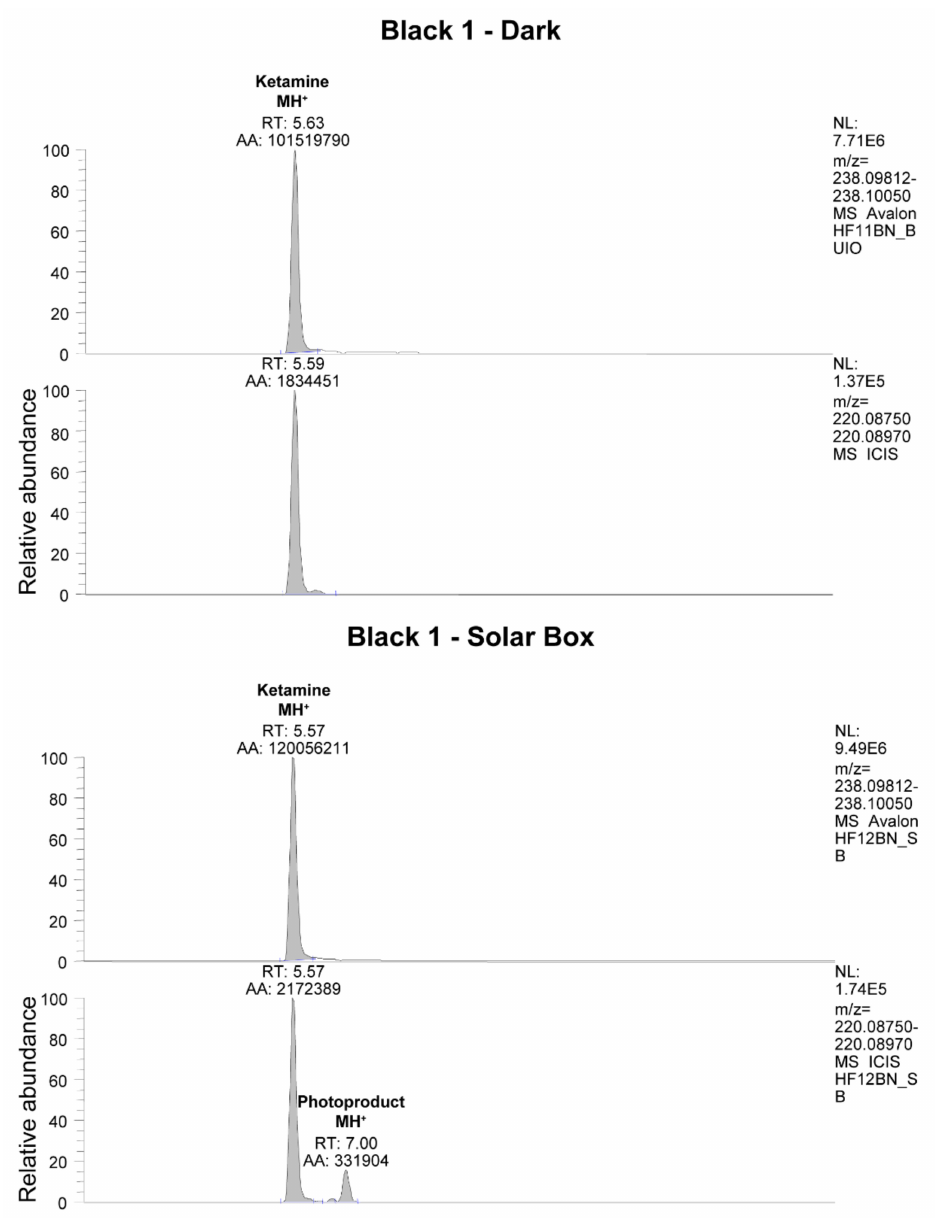
Figure 8. LC-HRMS analysis of hair sample Black 1 taken in the dark and after irradiation in the solar simulator. In the irradiated sample, the presence of a KET photoproduct with 220.08750 m / z is